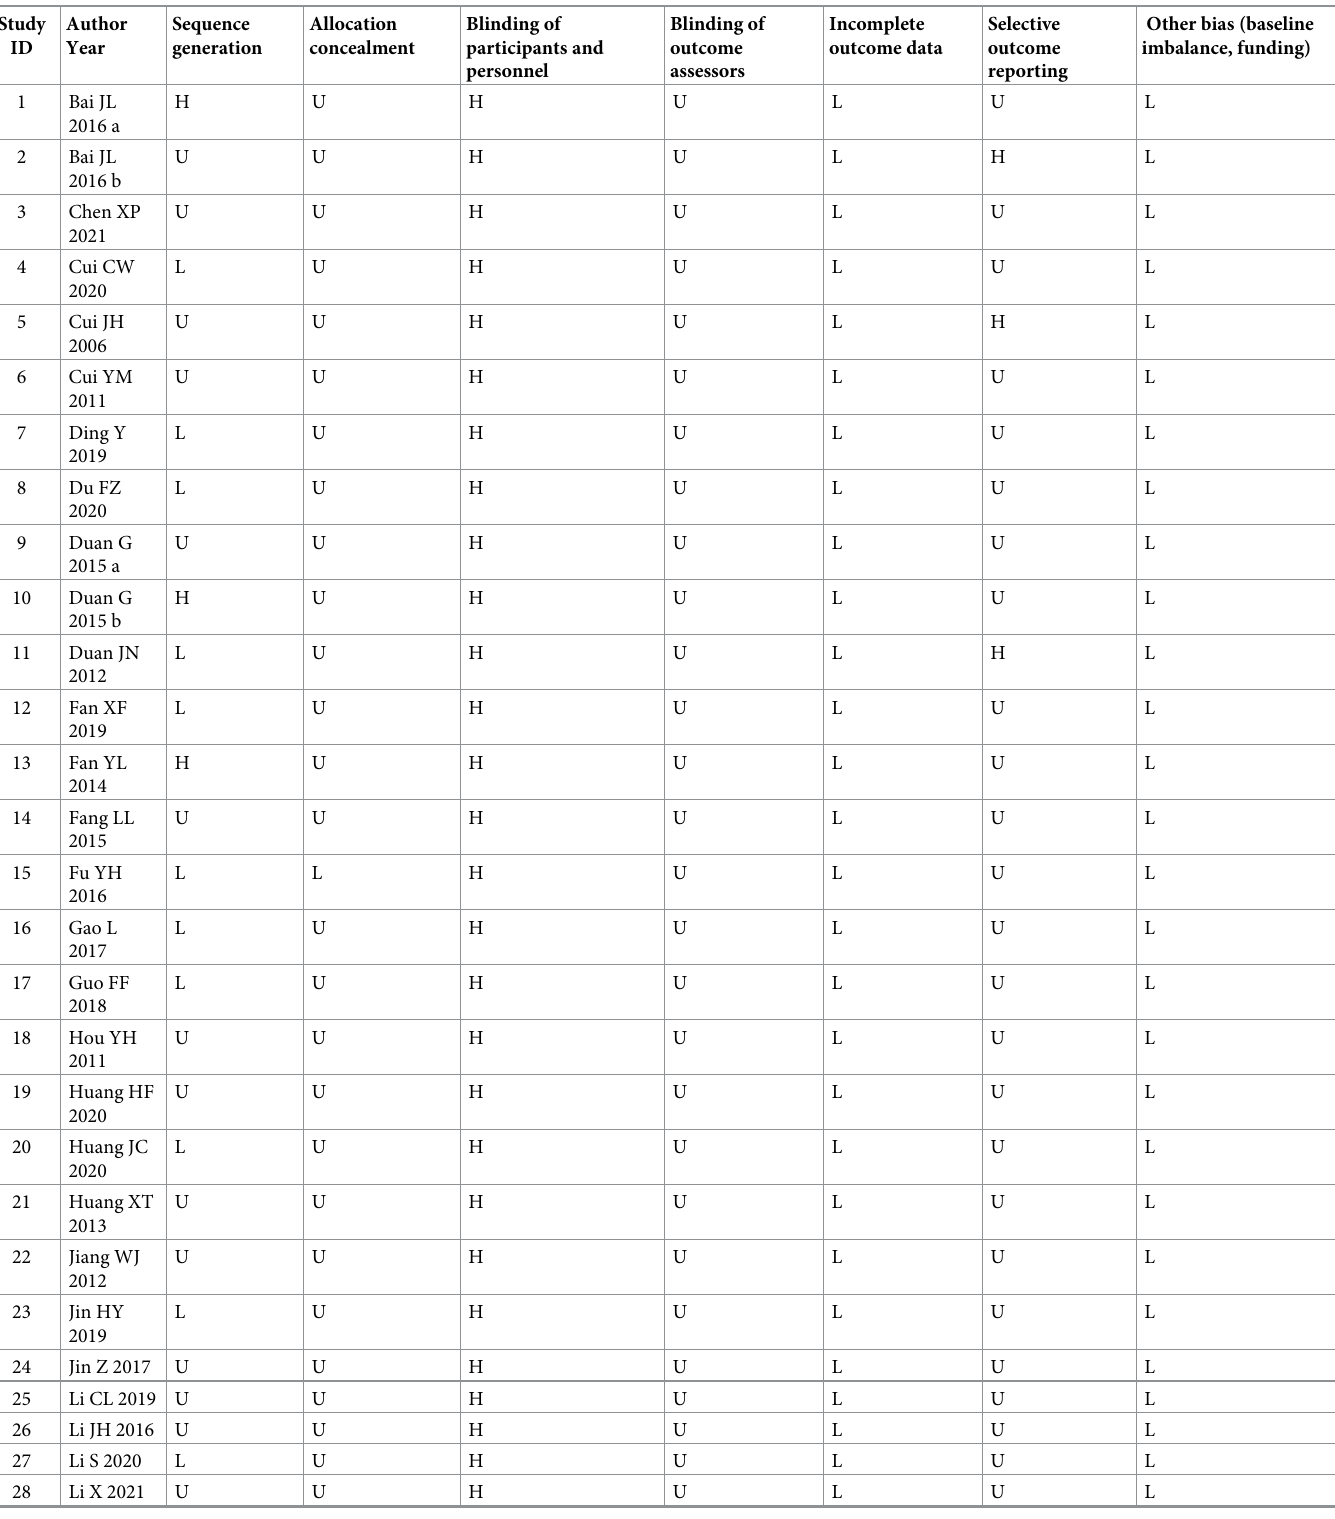
Table 2. Risk of bias assessments of the included